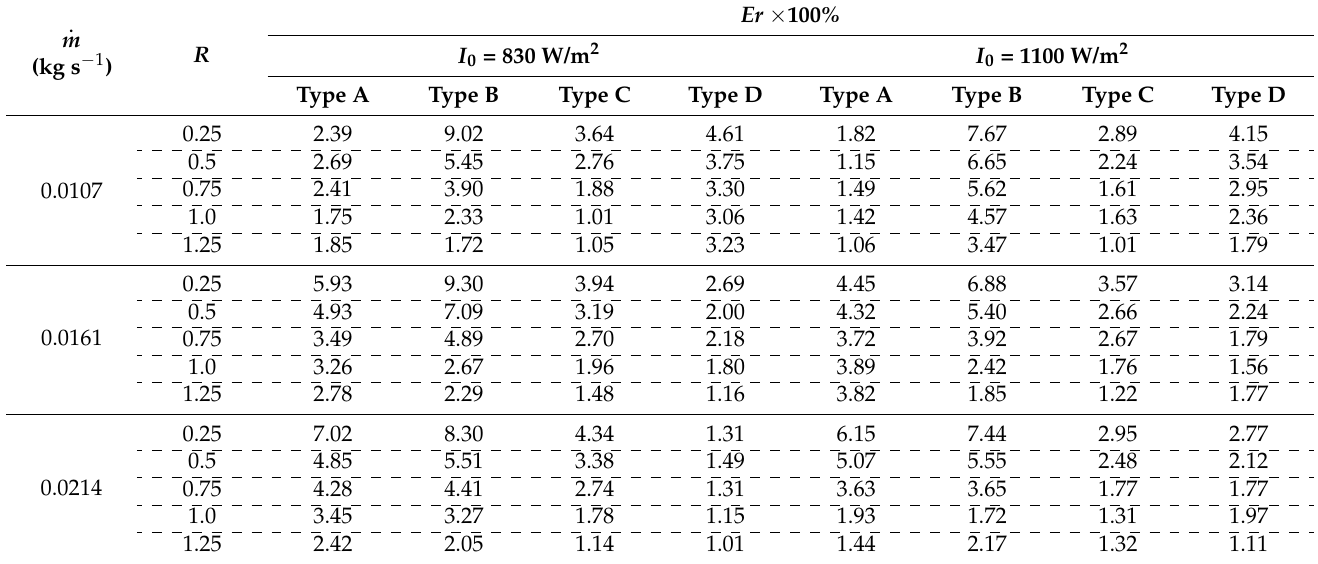
Table 5. The accuracy deviation between theoretical predictions and experimental results. .